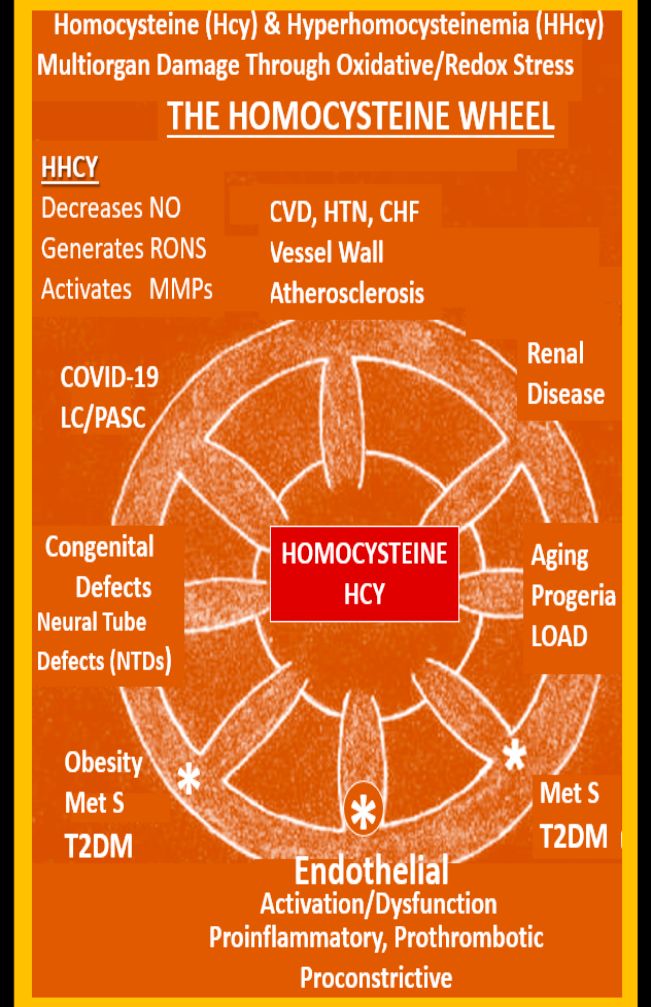
Figure 11. The Homocysteine Wheel. This illustration depicts the central importance of homocysteine (Hcy) in its hyperhomocysteine (HHcy) state as it relates to the multiorgan tissue damage and associated multiple clinical diseases, which now includes the COVID-19 post-viral syndrome of LC/PASC. HHcy generates damage to proteins, lipids and nucleic acids as result of oxidative redox stress and the generation of excessive reactive oxygen nitrogen species (RONS). In HHcy, Hcy undergoes autoxidation, formation of Hcy mixed disulfides, interaction of Hcy thiolactones and protein homocysteinylation reactions, which result in damage and dysfunction to proteins, tissues and organs. Note the large asterisk at the central bottom of this illustration where the effects of HHcy promotes the uncoupling of the endothelial nitric oxide synthase enzyme (eNOS) by oxidizing the tetrahydrobiopterin (BH4) co-enzyme of eNOS and thus promotes an even further production of superoxide while it concurrently decreases the bioavailability of nitric oxide (NO), thus important to normal endothelial cell dysfunction. As a result, the endothelium undergoes activation and dysfunction and becomes a proinflammatory, prothrombotic endothelium due to increased generation of RONS. While this review has focused primarily on COVID-19 and LC/PASC, this illustration demonstrates that HHcy affects many other tissues, organs and clinical diseases. This modified image is reproduced with permission by CC 4.0 [6]. CHF = congestive heart failure; COVID-19 = coronavirus disease-19; CVD = cebro-cardiovascular disease; HTN = hypertension; MetS = metabolic syndrome; MMPs = matrix metalloproteinases; NTD = neural tube defects; LC/PASC = Long COVID/ post-acute sequelae of SARS-CoV-2; LOAD = late-onset Alzheimer’s disease; T2DM = type 2 diabetes mellitus